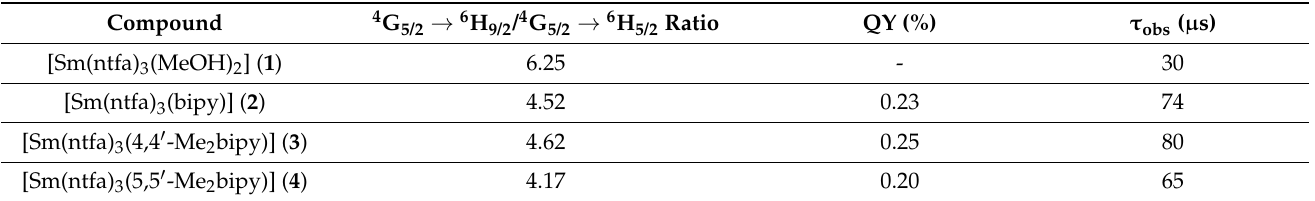
Table 4. Compilation of the photoluminescent data of compounds 1 – 4 . QY stands for the overall quantum yield, and τ obs for the emission time delay.